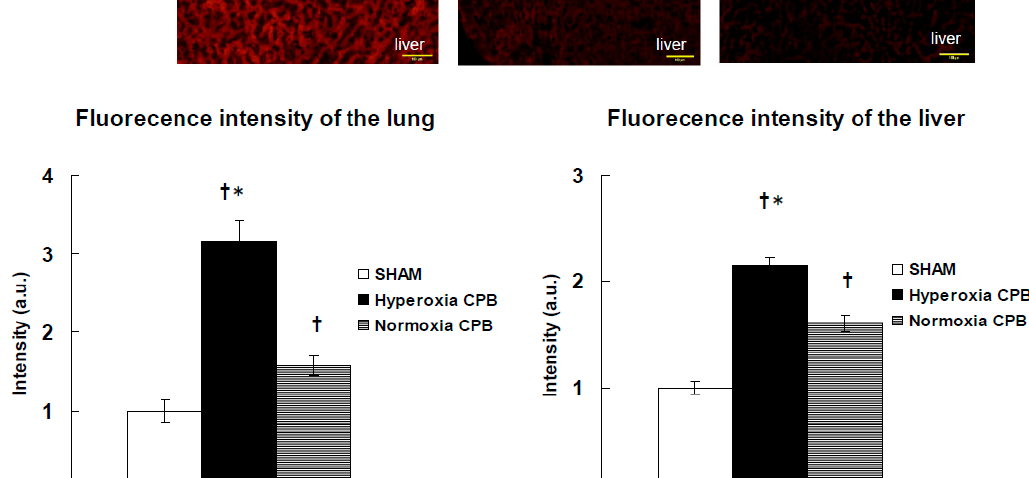
Figure 5. Detection of superoxide production in liver and lung tissues. ( a ) Representative examples of in situ detection of superoxide in each group’s lung and liver. Confocal microscope sections of organ are labeled with the fluorescent oxidative dye dihydroethidium [25]. Scale bar: 100 µ m. ( b ) Mean fluorescence intensity after deducting the values of SHAM. † p < 0.05 versus SHAM group, * p < 0.05 versus Normoxia CPB group [15]. a.u.: arbitrary units.